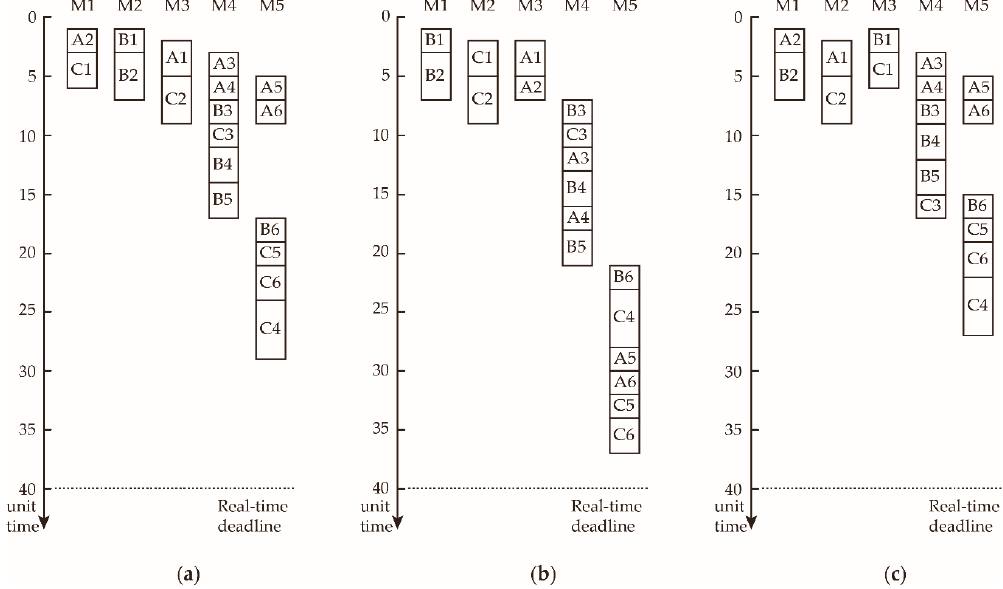
Figure 3a–c denotes the schematics of three scheduling algorithms: shortest processing time (SPT), round-robin (R-R), and HEFT. No constraint connection is depicted on the graph for clarity. The constraint relation between the tasks is shown on the edges of Figure 2. Electronics 2019 , 8 , x FOR PEER REVIEW